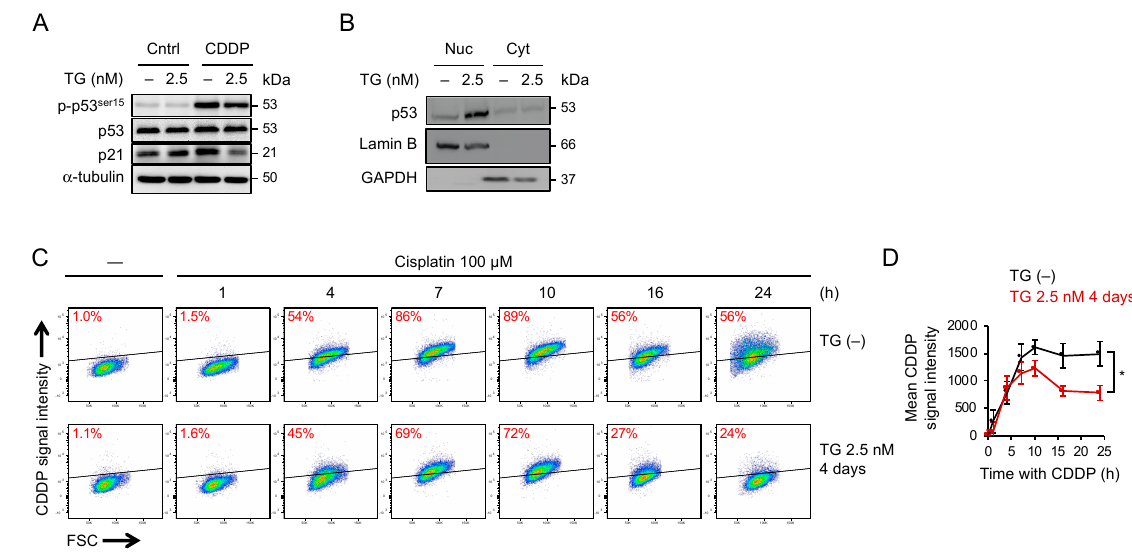
Figure 6. Adaptation to prolonged ER stress enhance p53–p21 prosurvival axis and decreases accumulation of cisplatin- induced DNA damage. OECM1 cells with or without 4 days of 2.5 nM thapsigargin pretreatment were treated with 100 µM of cisplatin for 1 day, and ( A ) the expression of phosphorylated p53 at Ser51, p53, and p21, ( B ) nuclear vs. cytoplasmic fraction of p53, and ( C ) chromatin-bound vs. nuclear fraction of p53, were examined by Western blots. The α -tubulin, Lamin B, GAPDH, and Histone H3 were used as the loading control. ( D ) Representative flow cytometry analysis of the levels of cisplatin-DNA lesions 1, 4, 7, 10, 16, and 24 h after cisplatin treatment. Data from three independent experiments are shown as the mean ± SEM. Statistical significance was determined by one-way ANOVA. *, p < 0.05.